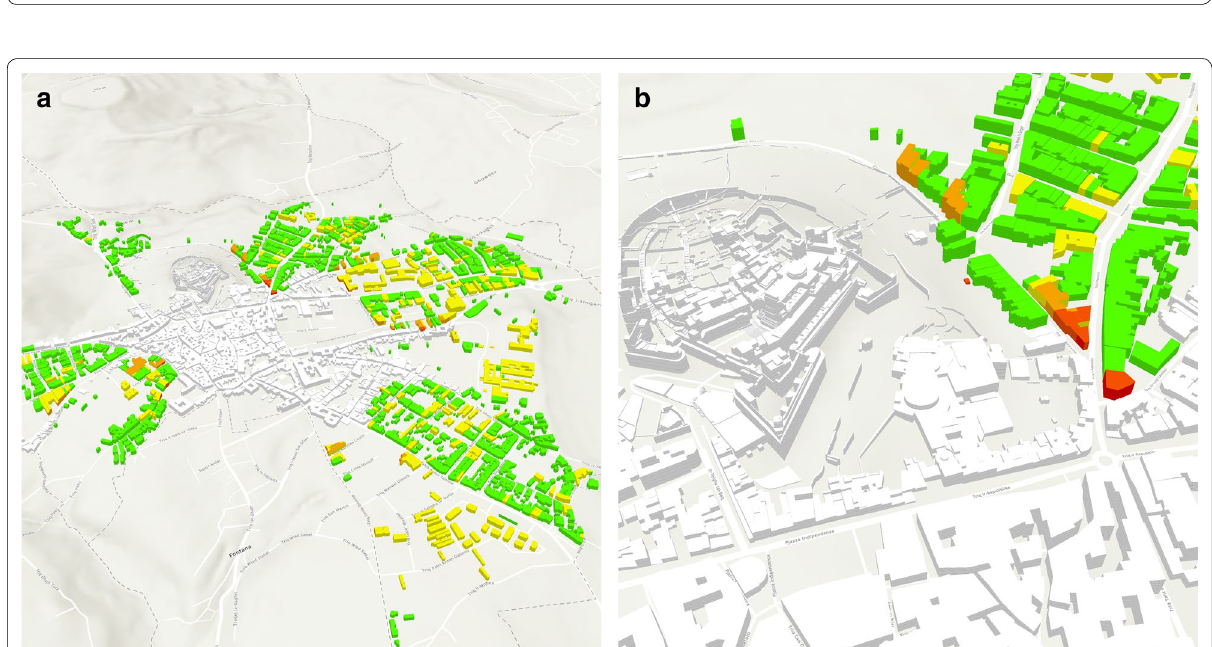
Fig. 7 a Visible area percentage: very low visibility (yellow); low visibility (light orange); average visibility (dark orange); high visibility (red). The white buildings are the UCAs; the green buildings have been increased in volume. The visibility analyses measure the percentage of visible area of the historic center from the non-transformed buildings. Victoria: potential future development. b Visible area percentage: very low visibility (yellow); low visibility (light orange); average visibility (dark orange); high visibility (red). Victoria: potential future